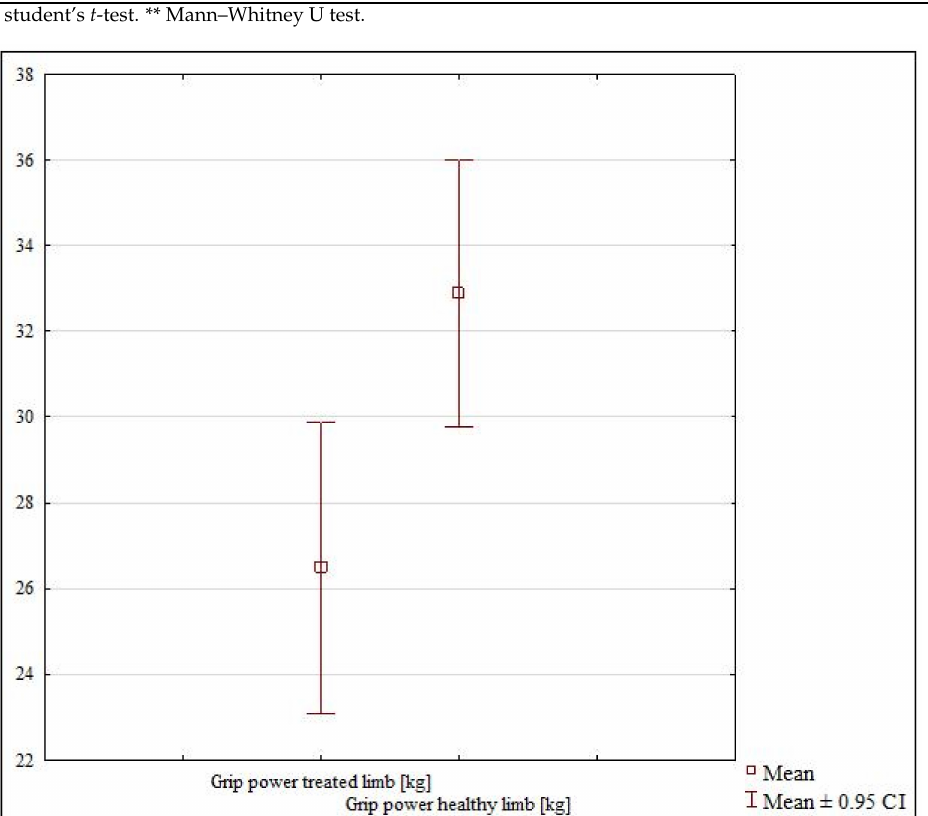
Figure 3. The grip strength in the healthy and treated limb in 6-week subgroup. The mean wrist flexion measured in all study subjects was 67.9 ◦ in the treated limb and 84.4 ◦ in the healthy limb. The best range of flexion (74.9 ◦ ) was achieved in the 6-week subgroup, and the most limited flexion (61.5 ◦ ) was observed in the 4-week subgroup. These differences were significant ( p = 0.025) (Table 1, Figure 4). The 4-week immobilization subgroup exhibited significant differences in wrist flexion between the healthy and